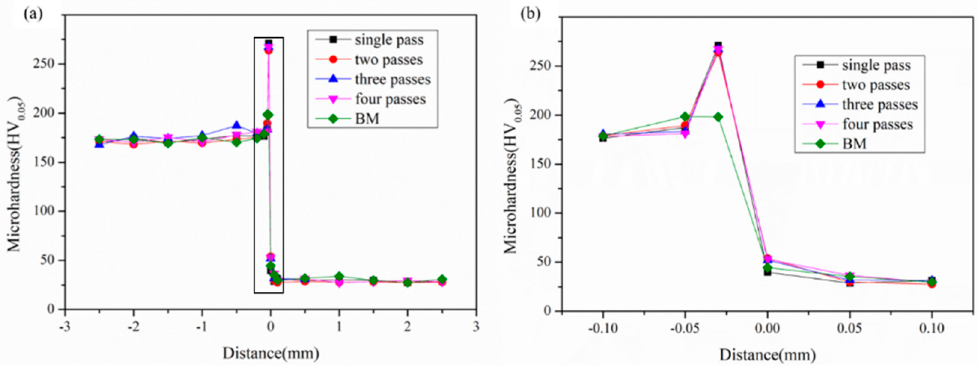
Figure 13. Microhardness of composite plate after FSP with different passes: ( a ) hardness of whole specimens; ( b ) hardness for the samples near the interface (partial enlargement of Figure 13a).